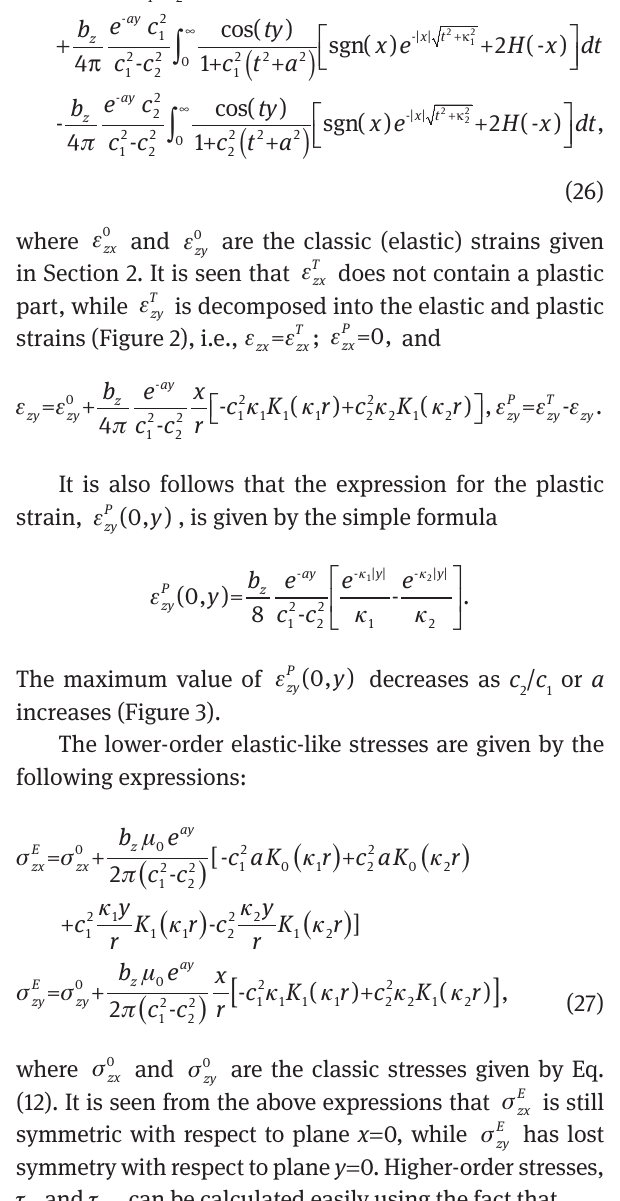
Figure 6 Comparison between double stresses within the first strain gradient (dashed lines) and the second strain gradient (solid lines). It is apparent that τ